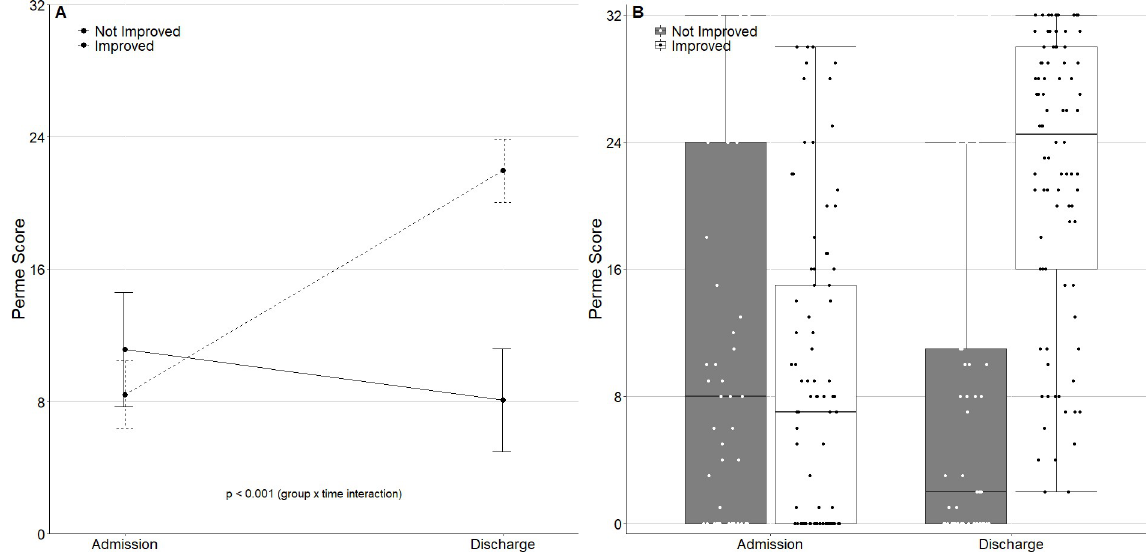
Fig 1. A. Mean and standard deviation of the Perme Score at ICU admission and discharge between patients that improved and did not improve the PMI during ICU stay ( light grey line represents the group of patients that “not improved” and dark grey line represents the group of patients that “improved”). B. Boxplot of Perme Score between groups and between ICU admission and discharge in these groups ( light grey box represents the group of patients that “not improved” and dark grey box represents the group of patients that “improved”). Definition of abbreviations : ICU = intensive care unit; PMI = perme mobility index; ICU LOS = intensive care unit length of stay.